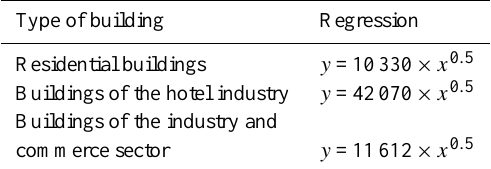
Table 1. Absolute damage functions resulting from the survey after the flood event 2005 in Tyrol (TYROL